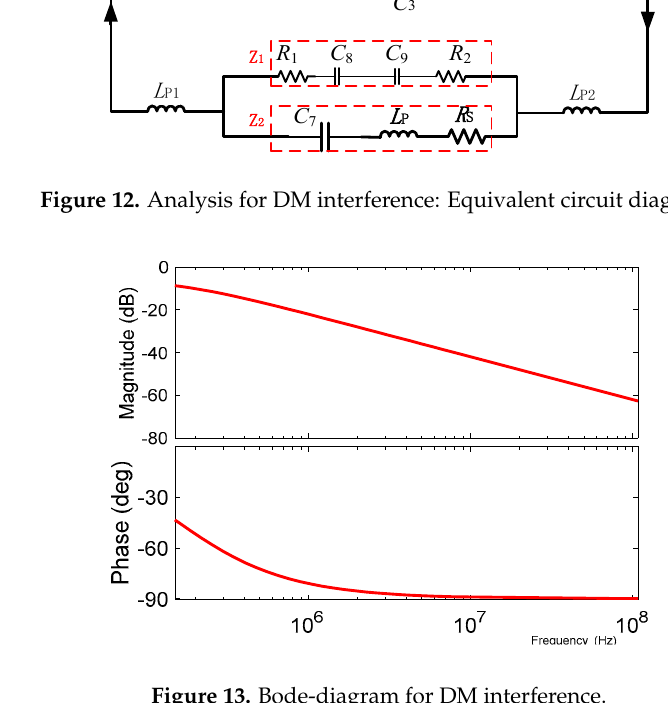
. Figure 14. Analysis for CM interference: EMI current path. This part of the interference current may generate conducted-EMI from DC power cables at ground side and battery side in EVs, so it is significant to predict the CM interference of WCS. An equivalent circuit of the CM interference paths is shown in Figure 15, R L2 and L2 are divided equally into RL2-1, RL2-2 and L2-1, L2-2. In Figure 15, you can see Z 1 , Z 2 , Z 3 , Z 4 and Z 5 and Z 6 which represent a part of circuital impedance, respectively. And the function was established by Equations (7)–(12). The relationship between the output noise energy and the input noise energy in the system is given by transfer function in Equation (13). Then, the bode-diagram of the transfer function is drawn, as shown in Figure 16. From Equation (13) and Figure 16, some CM interference elements in the frequencies range of 150 kHz–180 MHz can be illustrated. S 1